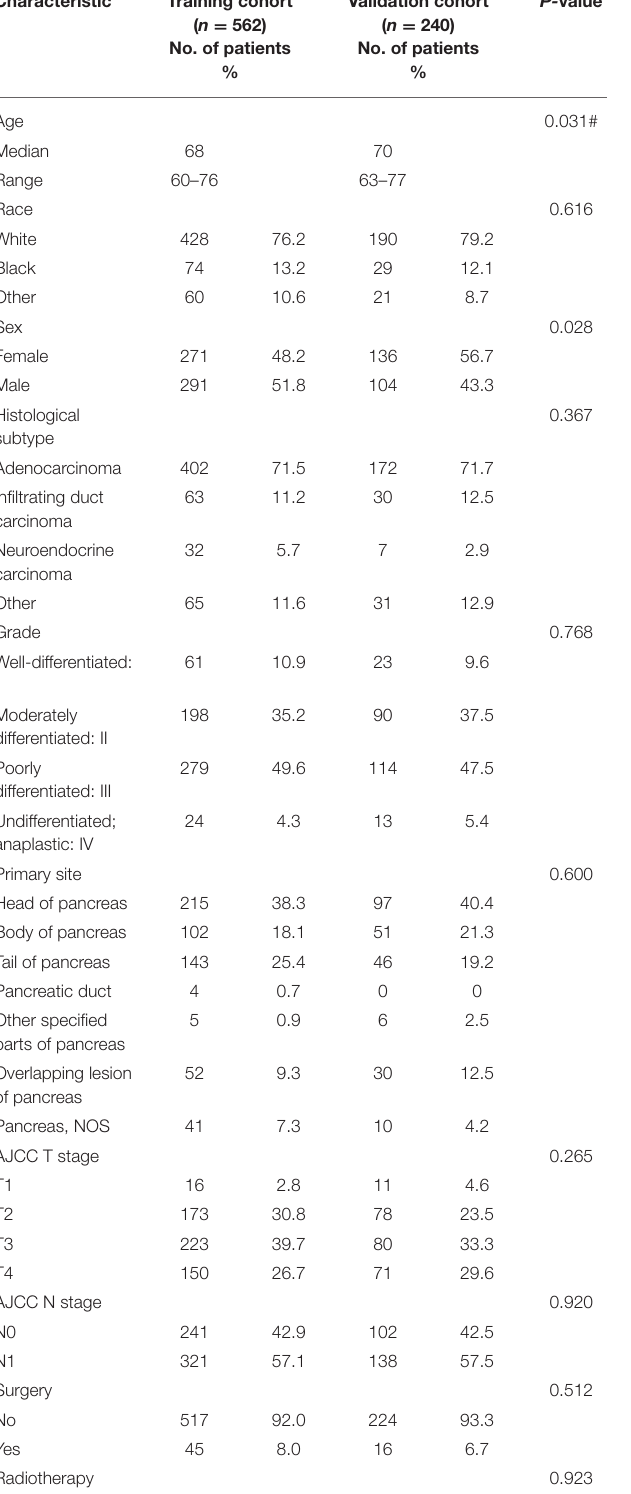
TABLE 4 | Demographic and clinicopathological characteristics in pancreatic cancer patients with lung metastasis.